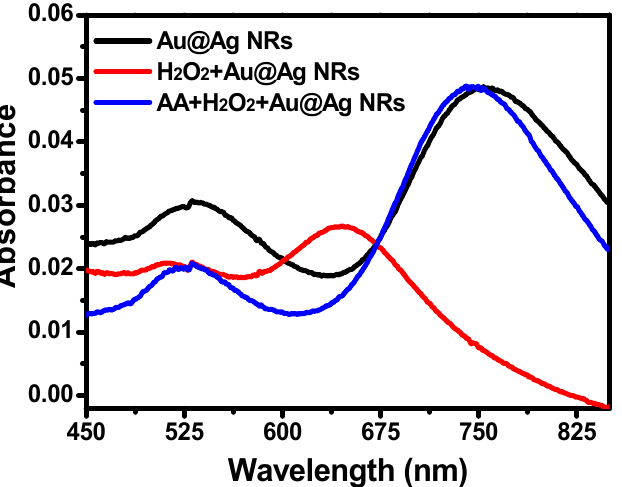
Figure 1. Absorption spectra of silver-coated gold nanorods in the presence of H 2 O 2 and AA. Con- ditions: Au@Ag NRs, 50 μ L; H 2 O 2 , 450 μ M; Fe 2+ ; 0.25 mM; HCl, 0.10 M; t , 25 min; T, 45 °C; and AA,